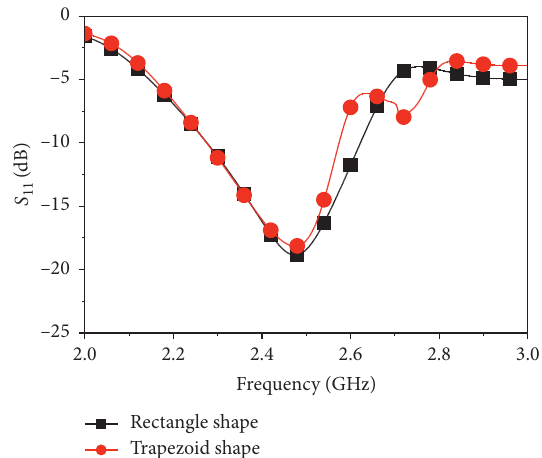
Figure 7: Reflection coefficients of the compact quasi-Yagi antennas.